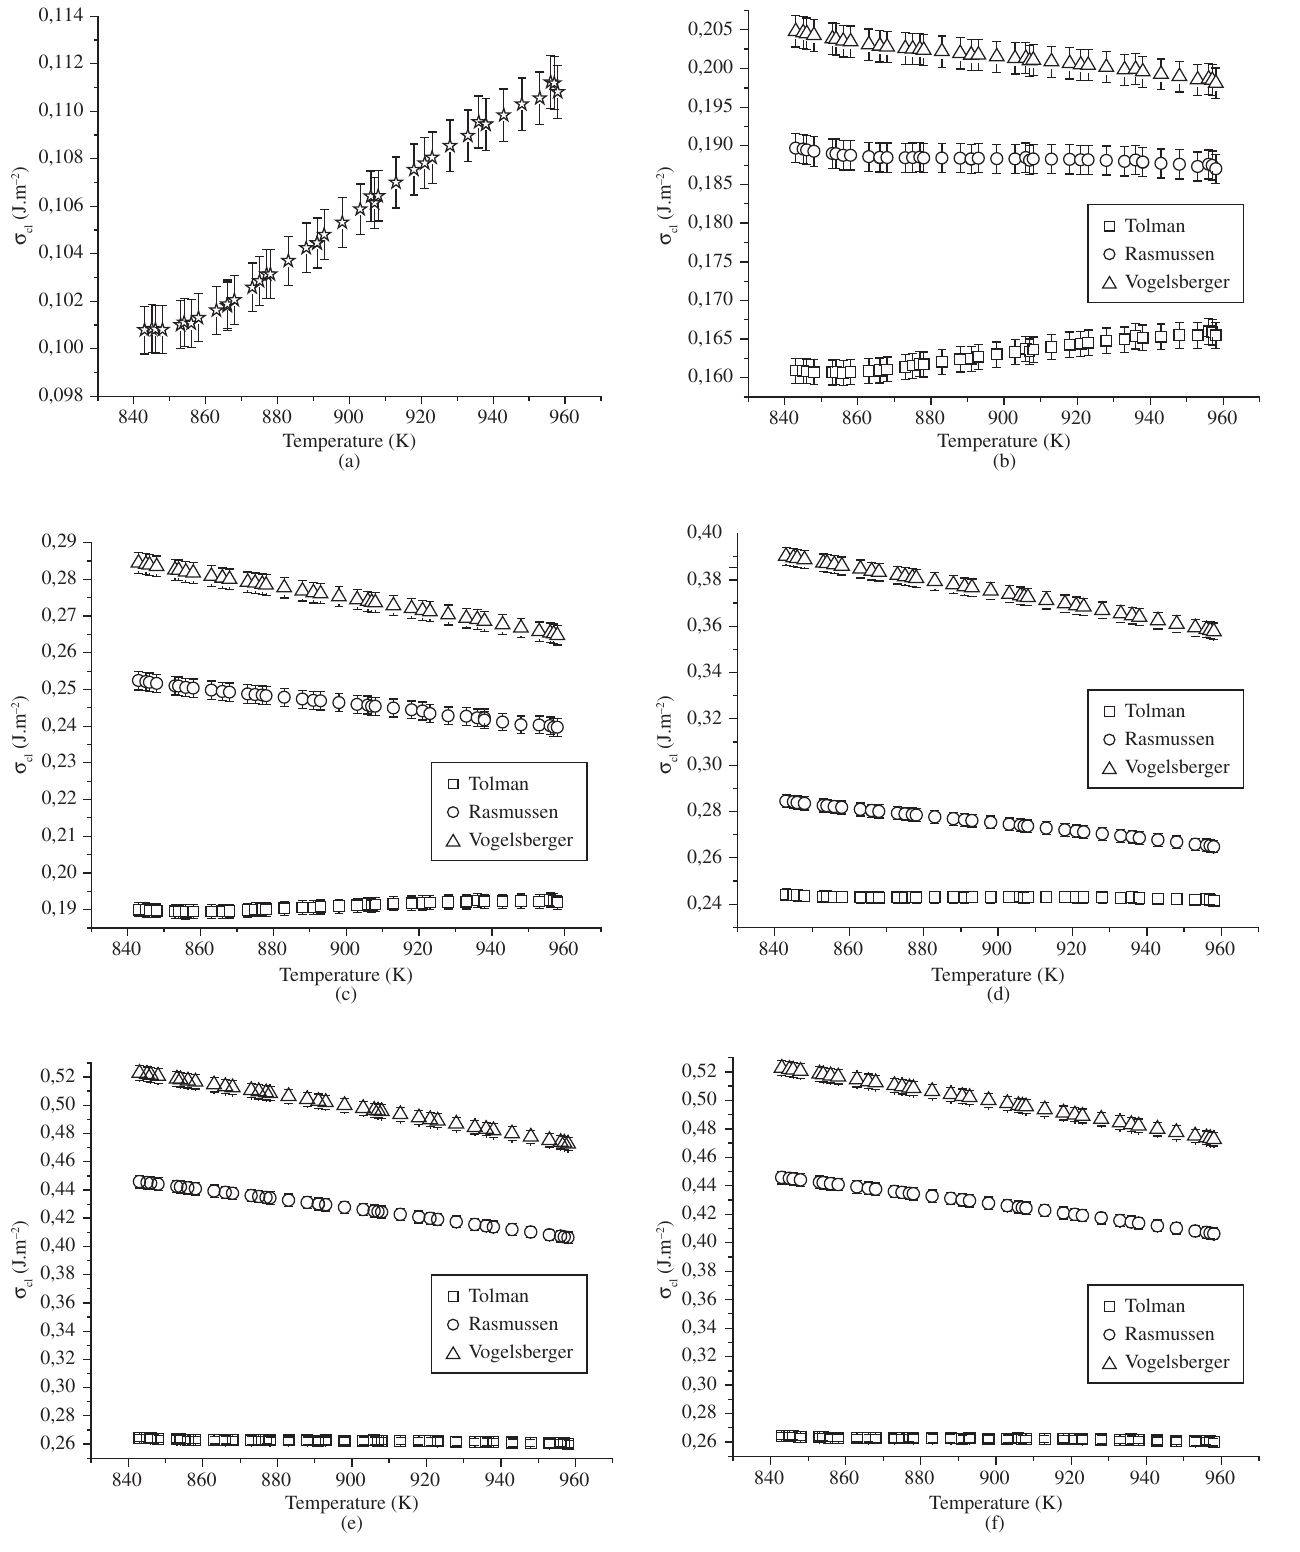
C S glass, using viscosity data and the equations proposed by Tolman 1 2 3